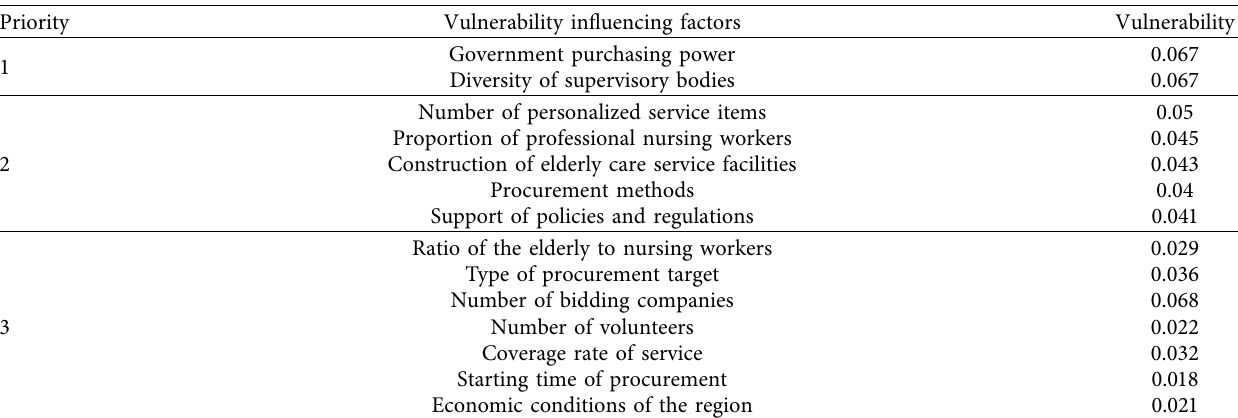
Figure 3: Results of node vulnerability. Table 8: Vulnerability value of